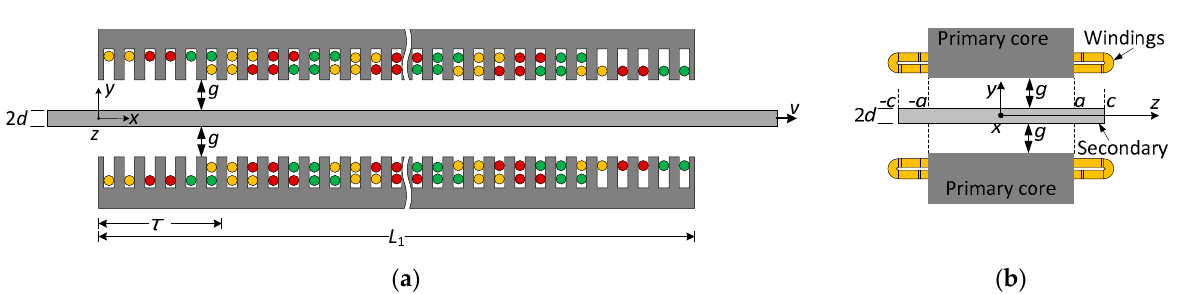
Figure 1. Structure of DLIM.